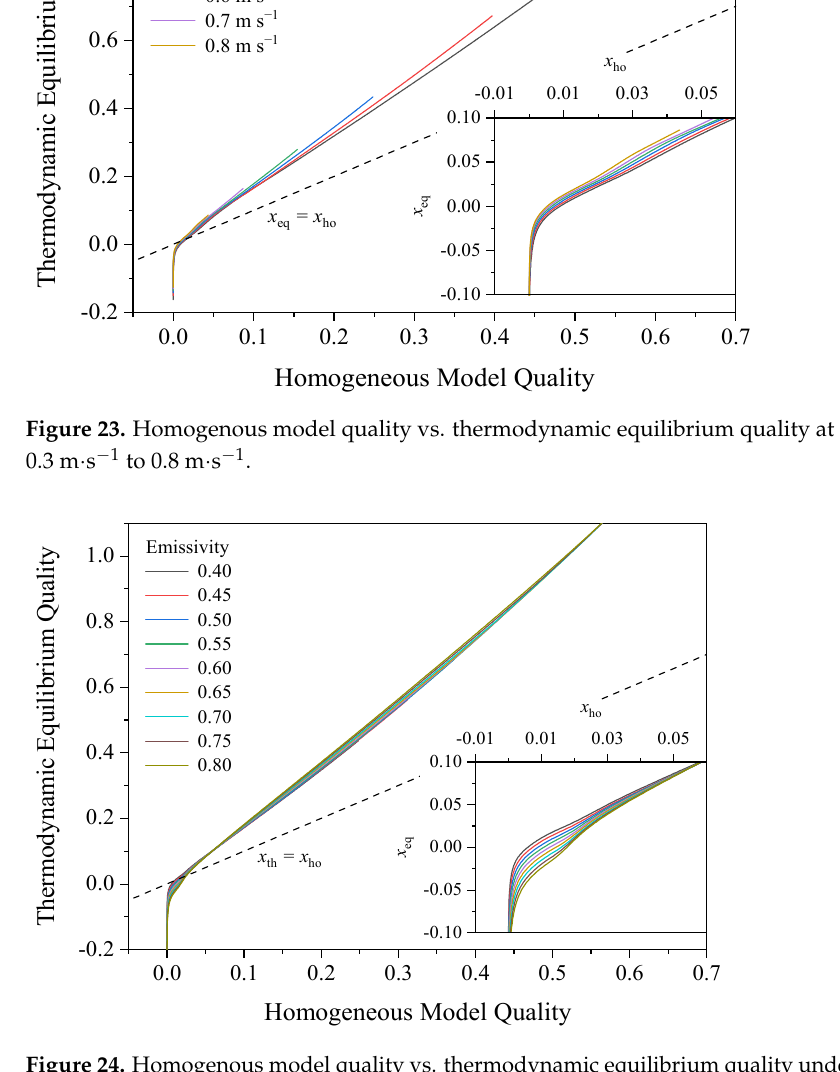
Figure 24. Homogenous model quality vs. thermodynamic equilibrium quality under wall emissivity of 0.40 to 0.80.